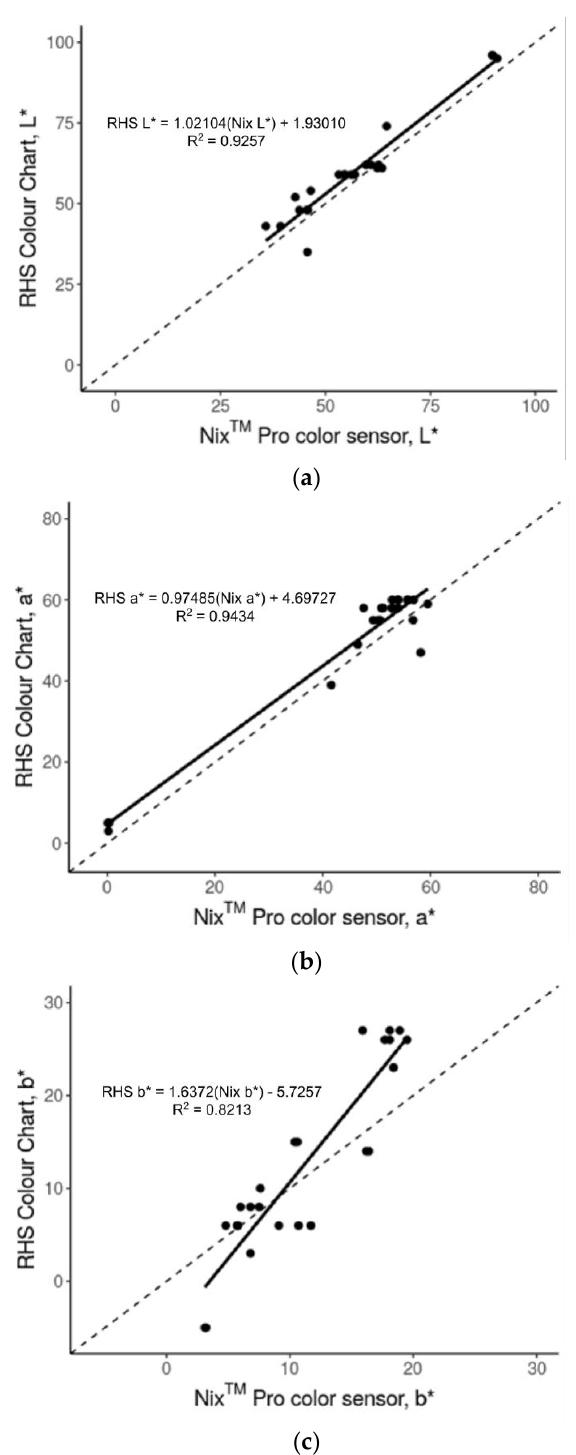
Figure 4. Comparison of Nix TM Pro sensor color values to Royal Horticultural Society (RHS) Colour Chart published values for: ( a ) L* (darkness to lightness), ( b ) a* (redness to greenness), and ( c ) b* (yellowness to blueness). The dashed line represents perfect agreement.